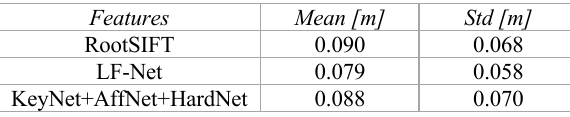
Table 5: Mean and standard deviation of the cloud-to-cloud differences.